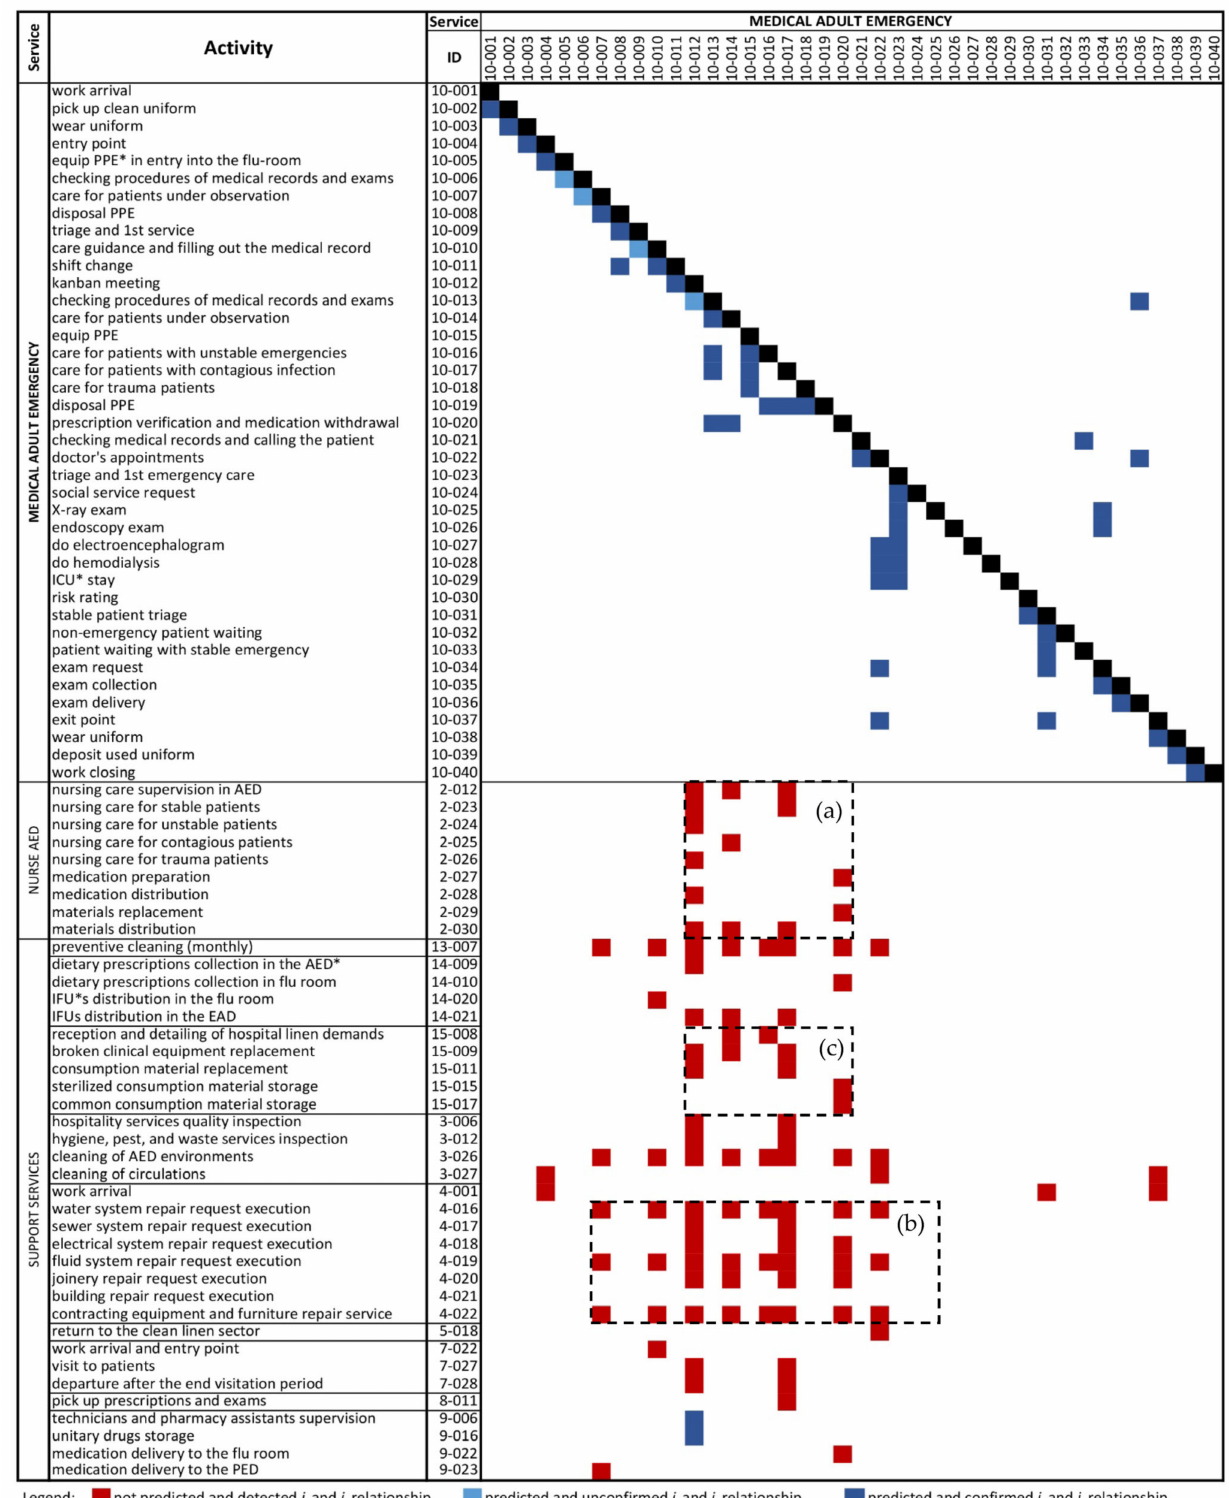
Figure 8. Detailed activity congruence matrix ( aC nn ), highlighting the relationships between the medical activities in ESs and other activities. Rows have been reordered to show the other activities that are related to the medical activities (see the full matrix in